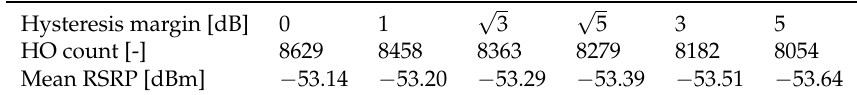
Table 1. Hysteresis margin effect on Reference Signal Received Power (RSRP) and handover (HO) count for BS1